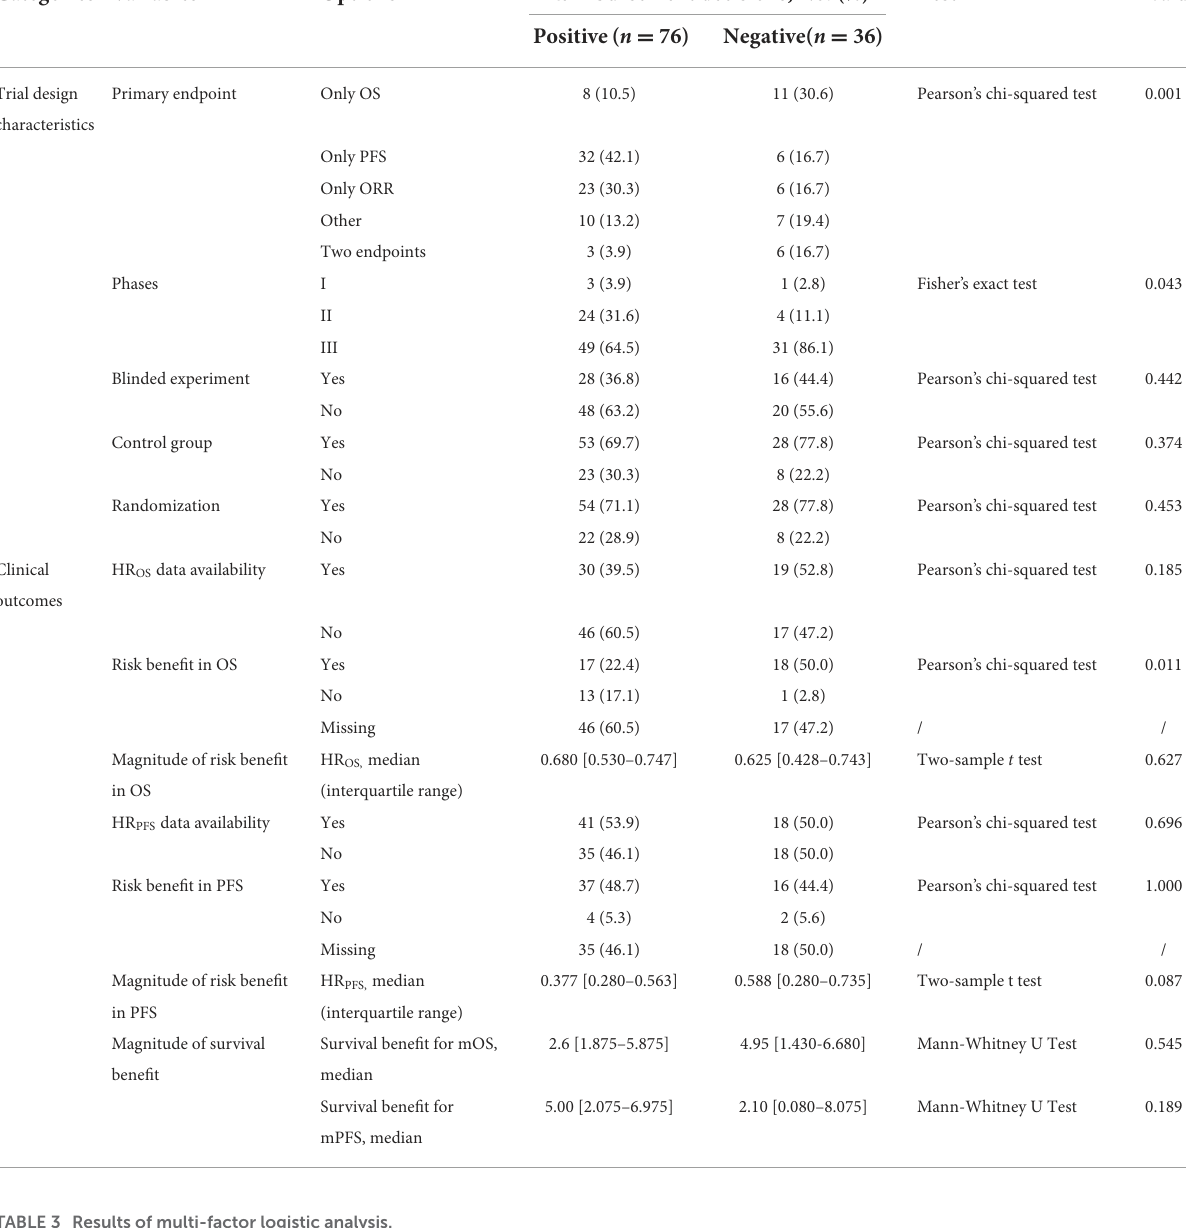
TABLE 2 Results of hypothesis testing.